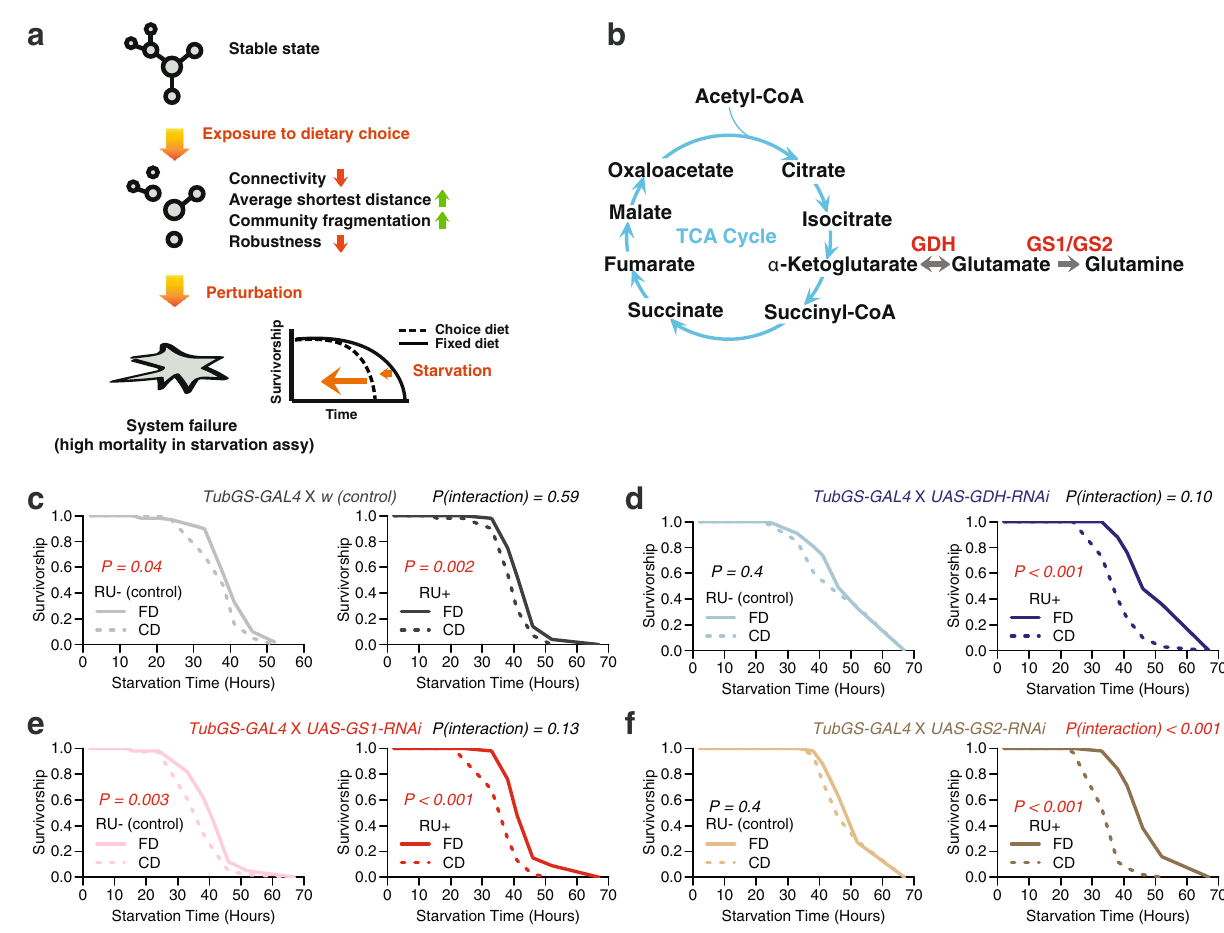
Fig. 6 Exposure to dietary choice increases vulnerability to genetic perturbations. a Our working model. b glutamine – α KG axis plays important roles in fueling the TCA cycle, one of the central biochemical reactions in metabolic networks. c – f Upon starvation, knocking down one of the key enzymes on the glutamine – α KG axis ( GDH , GS1 , and GS2 ) exacerbates the dietary effects on starvation resistance, suggesting fl ies that are preexposed to a choice diet are more sensitive to genetic perturbation. P values showing the dietary effects are obtained by log-rank test. We also use Cox-regression analysis to report P value for the interaction term between diet and genetic manipulation. Each treatment consists of six biological replicates ( N = 5 – 10 fl ies for each